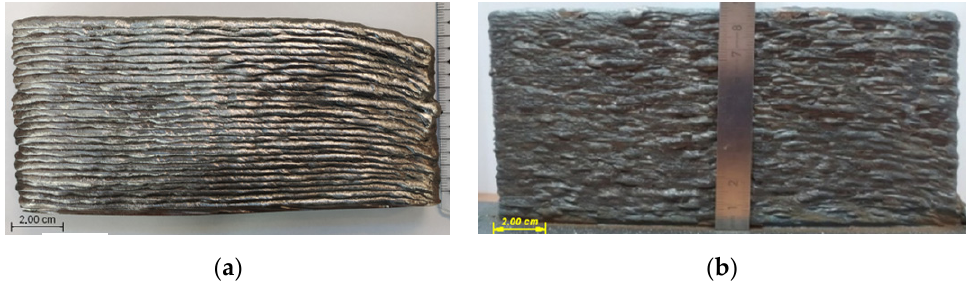
Figure 12. Appearance of the walls made in the mode I = 120 A U = 20 V, the feeding velocity is 3.2 m/min, the tool travel speed: ( a )—0.12 m/min, ( b )—0.24 m/min.